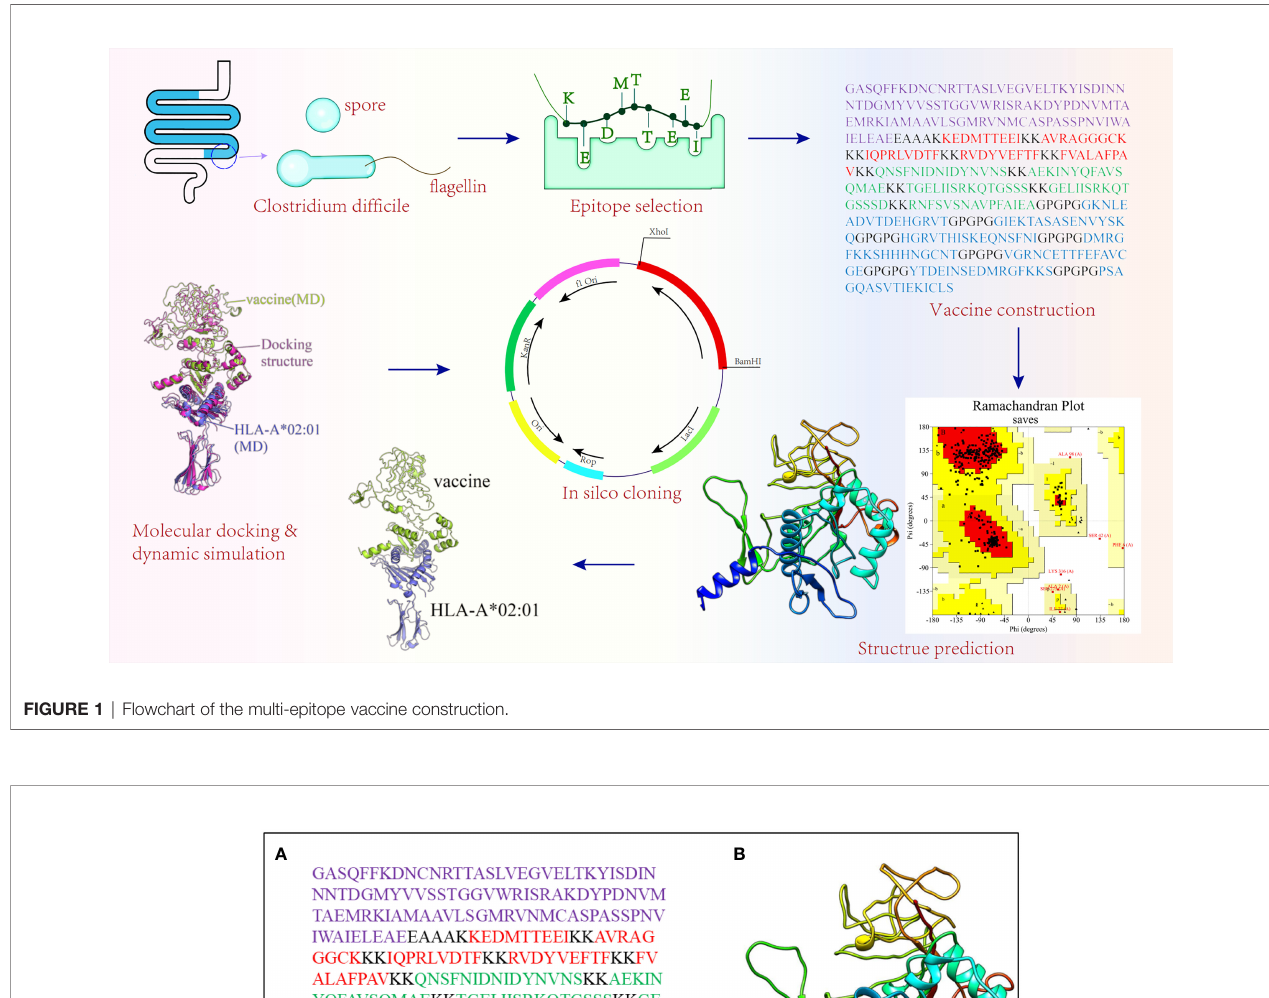
FIGURE 2 | (A) The fi nal vaccine sequence; purpledenotes adjuvant, Cytotoxicity T Lymphocytes (CTL)epitopes are colored red, Helper T lymphocyte (HTL)epitopes are colored green,B-cell epitopes are colored blue, and allof them are coupled via different connectors. (B) The three dimensional (3D)structure of the vaccine.